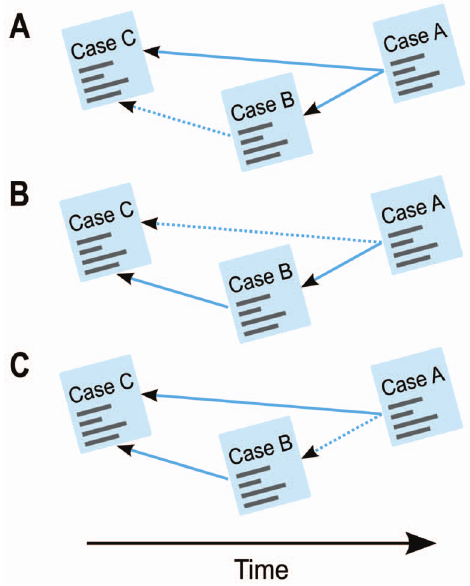
Figure 5. Three possibilities for completing triangles in the time-directed network of ECJ case law. Given two citations between three cases, A being more recent than B , which in turn is more recent than C , we can complete triangles in three different situations. Panel A: If a new case A cites two older cases B and C , but B does not cite C , we can make B cite C . Panel B: If a new case A cites B , and B